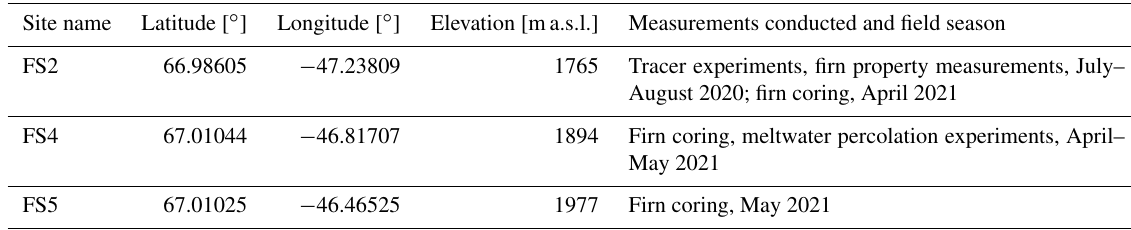
Table A1. Description of field sites where firn cores and shallow boreholes were drilled for tracer experiments and where meltwater perco- lation experiments were carried